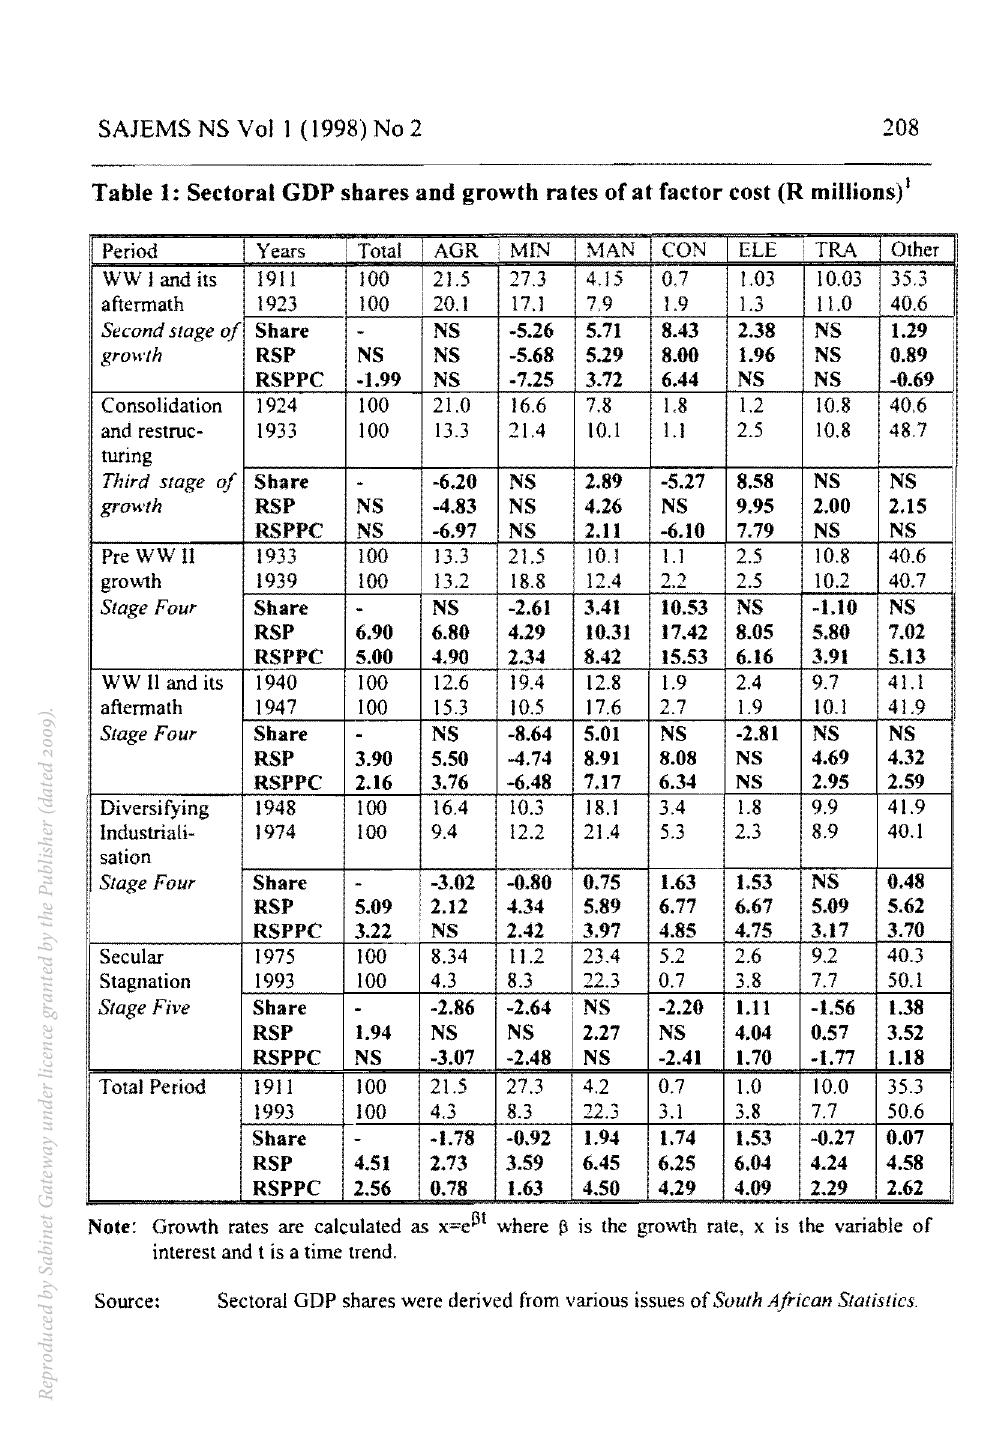
Table 1: Sectoral GDP shares and growth rates of at factor cost (R miliions)1